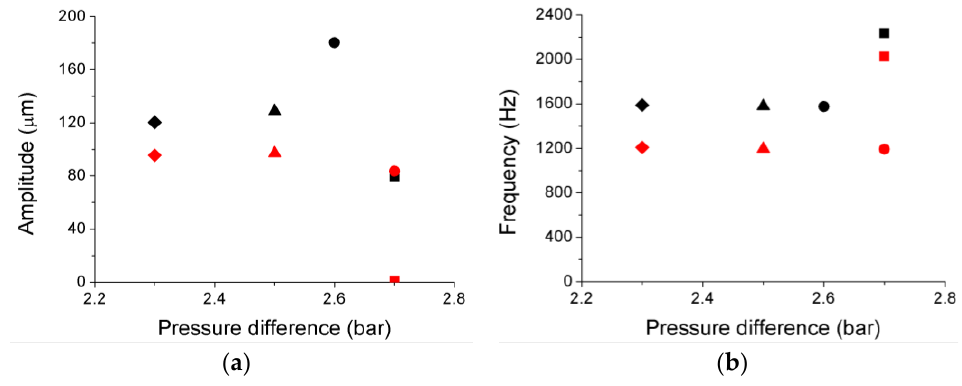
Figure 8. Vibration amplitude ( a ) and frequency ( b ) for the first Prototype (black) and the second Prototype (red) obtained by OFS 1 for the most similar working points (squares correspond to 0 rpm, circles to RPM nominal , triangles to 1.5 × RPM nominal and diamonds to 2 × RPM nominal ).